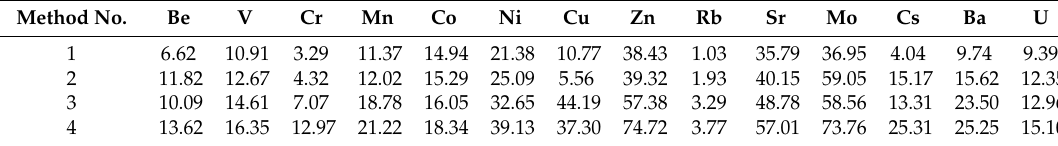
Table 4. The extraction rate of toxic elements from GH2 cleaned coal using HCl (%). Method